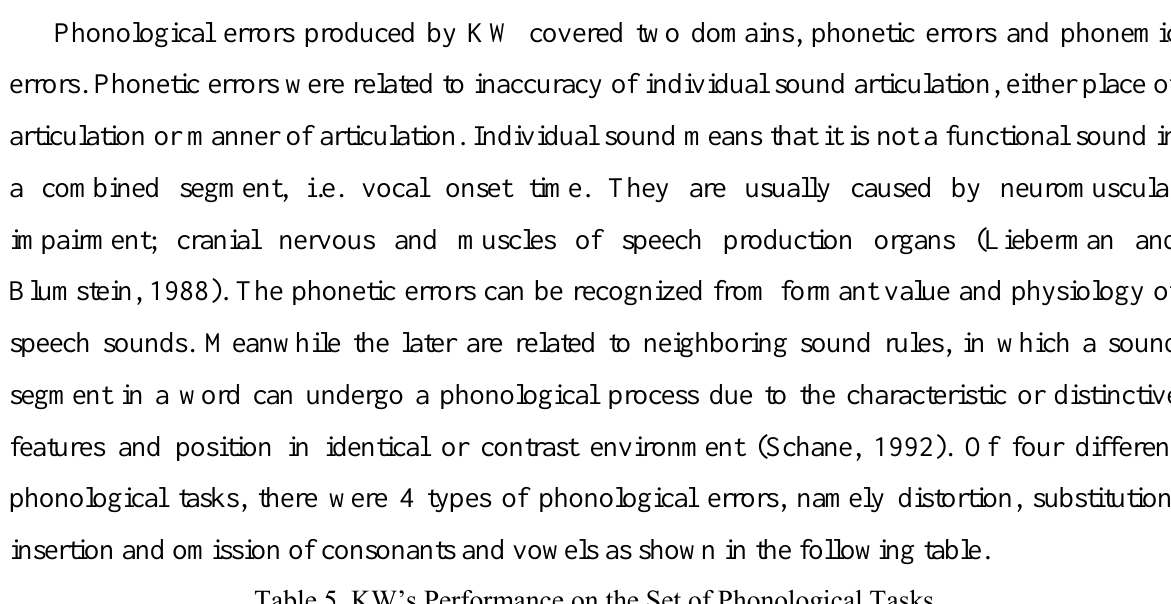
Table 5. KW’s Performance on the Set of Phonological